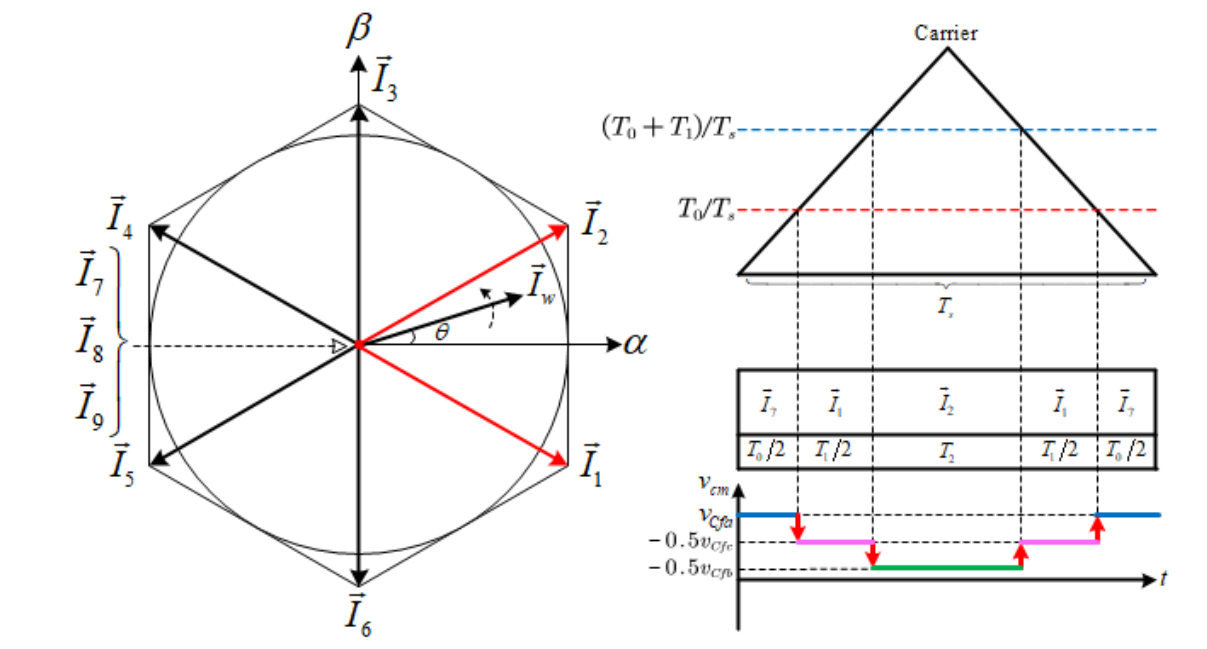
Figure 3. Five-segment sequence for conventional SVM .